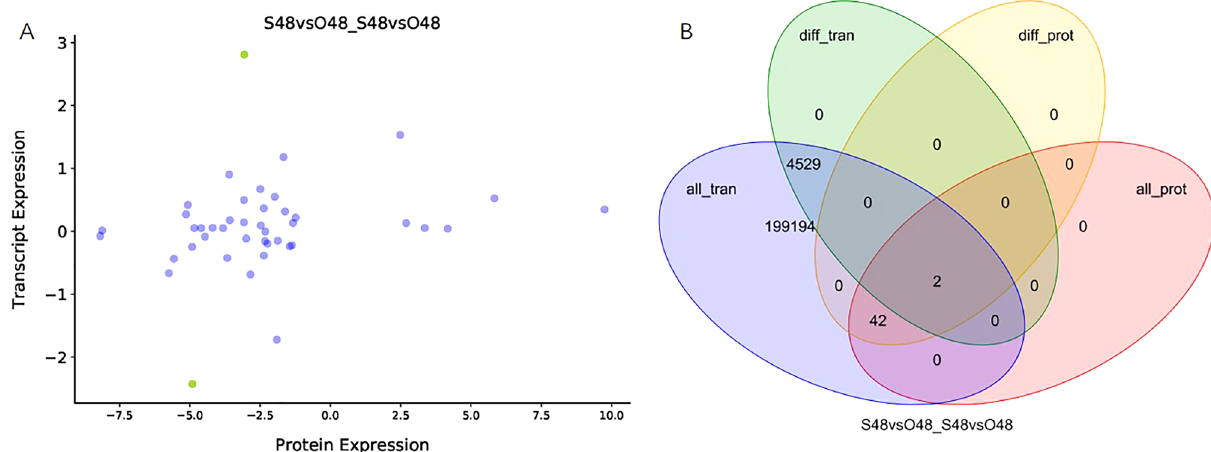
Figure 7. Association analysis between DEGs and DEPs. ( A ) Correlation scatter plot between DEGs and DEPs. The purple dots indicate the none significant difference protein, and the green dots indicate the significant difference protein. ( B ) Venn diagram showing the overlaps of RNA information obtained by transcriptome and protein information identified by the